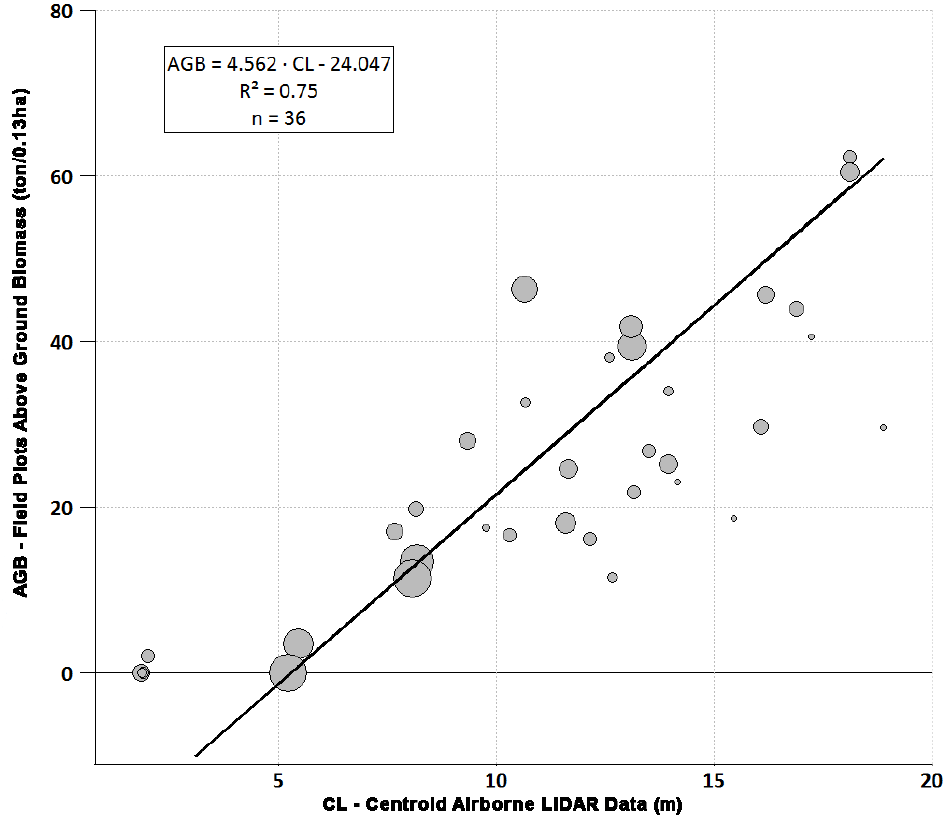
Figure 8. Scatter plot displaying the correlation between the Above Ground Biomass (AGB), calculated from field plots, to the centroid of the airborne LiDAR point cloud height histogram (CL). The sizes of the circles represent the average LiDAR point density per square meter (small = lower average LiDAR point density per square meter; big = higher average LiDAR point density per square